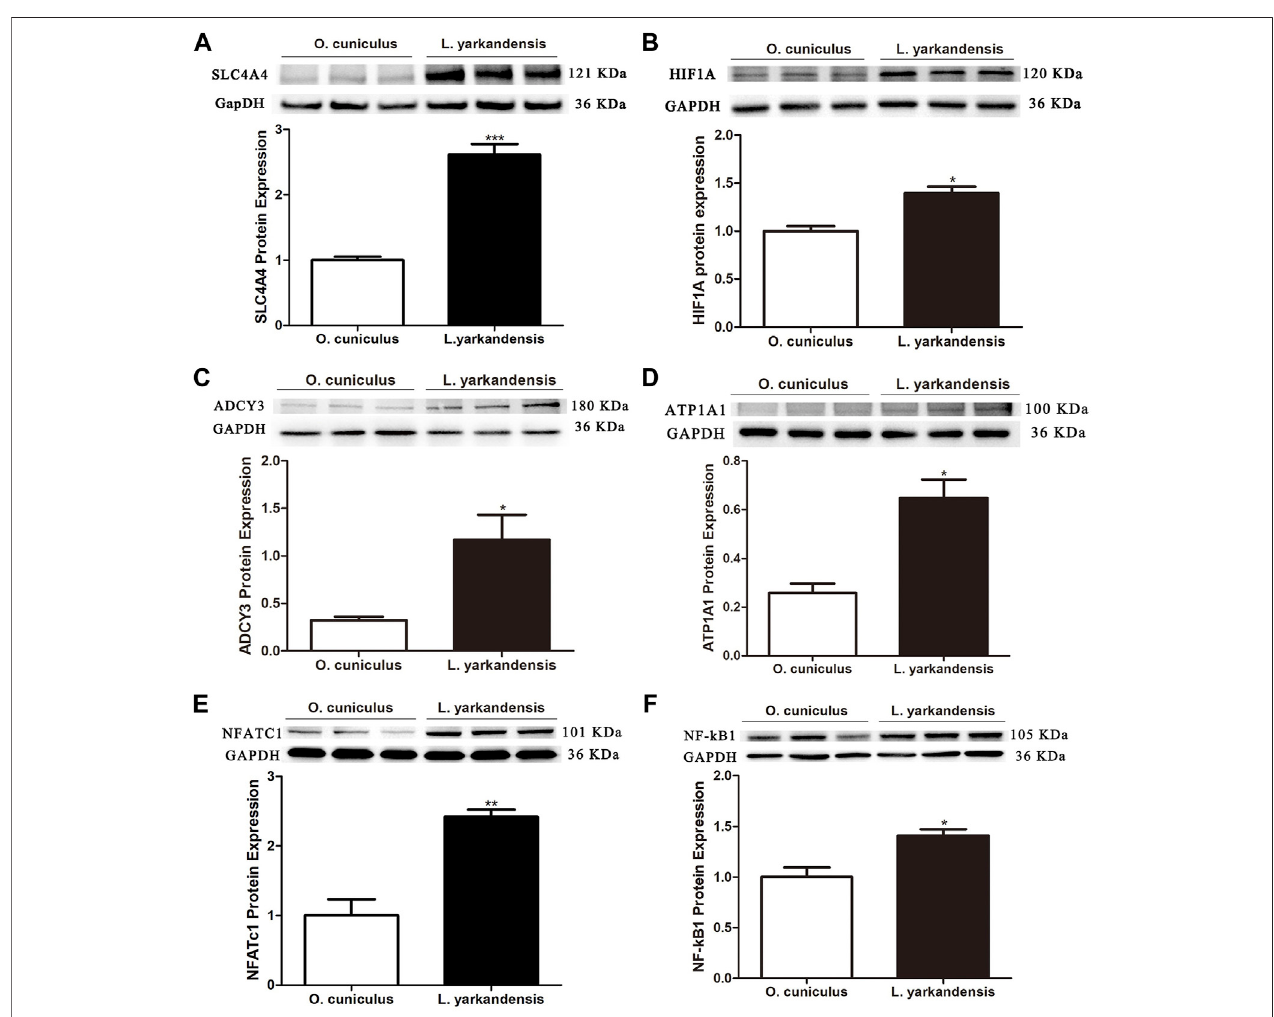
FIGURE 5 | Protein expression in kidney of O. cuniculus and L. yarkandensis . (A) (Top) Representative western blotting analyses of SLC4A4 protein expression in the renal of O. cuniculus and L. yarkandensis . Immunoblots of total proteins were probed with anti-SLC4A4 antibody and identi fi ed 121 kDa bands, while GAPDH antibody identi fi ed 36 kDa bands. (Bottom) Densitometry of all western blotting results of the renal of O. cuniculus and L. yarkandensis (n = 6 for each group); (B) (Top) Representativewesternblottinganalysesof HIF1A proteinexpressionintherenalof O.cuniculus and L.yarkandensis .(Bottom)Densitometryofallwesternblotting results of the renal of O. cuniculus and L. yarkandensis (n = 6 for each group); (C) : (Top) Representative western blotting analyses of ADCY3 protein expression in the renalof O.cuniculus and L.yarkandensis .(Bottom)Densitometryofallwesternblottingresultsoftherenalof O.cuniculus and L.yarkandensis (n=6foreachgroup); (D) : (Top) Representative western blotting analyses of ATP1A1 protein expression in the renal of O. cuniculus and L. yarkandensis . (Bottom) Densitometry of all western blottingresultsoftherenalof O.cuniculus and L.yarkandensis (n=6foreachgroup); (E) :(Top)Representativewesternblottinganalysesof NFATC1 proteinexpressionin therenalof O.cuniculus and L.yarkandensis .(Bottom) Densitometry ofallwesternblottingresults oftherenalof O.cuniculus and L. yarkandensis (n=6foreach group); (F) : (Top) Representative western blotting analyses of NF-kB1 protein expression in the renal of O. cuniculus and L. yarkandensis . (Bottom) Densitometry of all western blotting results of the renal of O. cuniculus and L. yarkandensis (n = 6 for each group); The histogram shows optical density analysis of western blot results, for ppp p < 0.001, pp p < 0.01, and p p < 0.05.